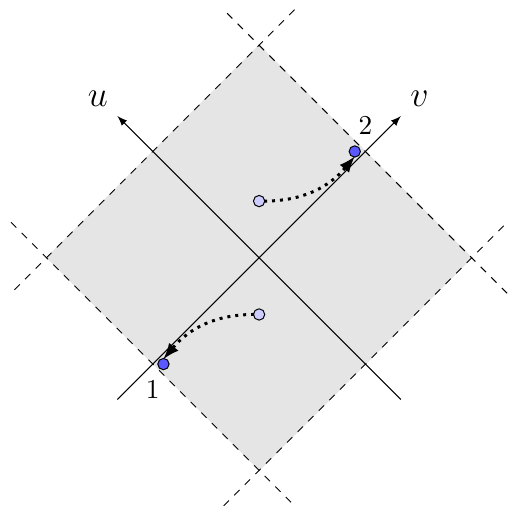
Figure 9 . The Regge-like limit of a pair of timelike-separated